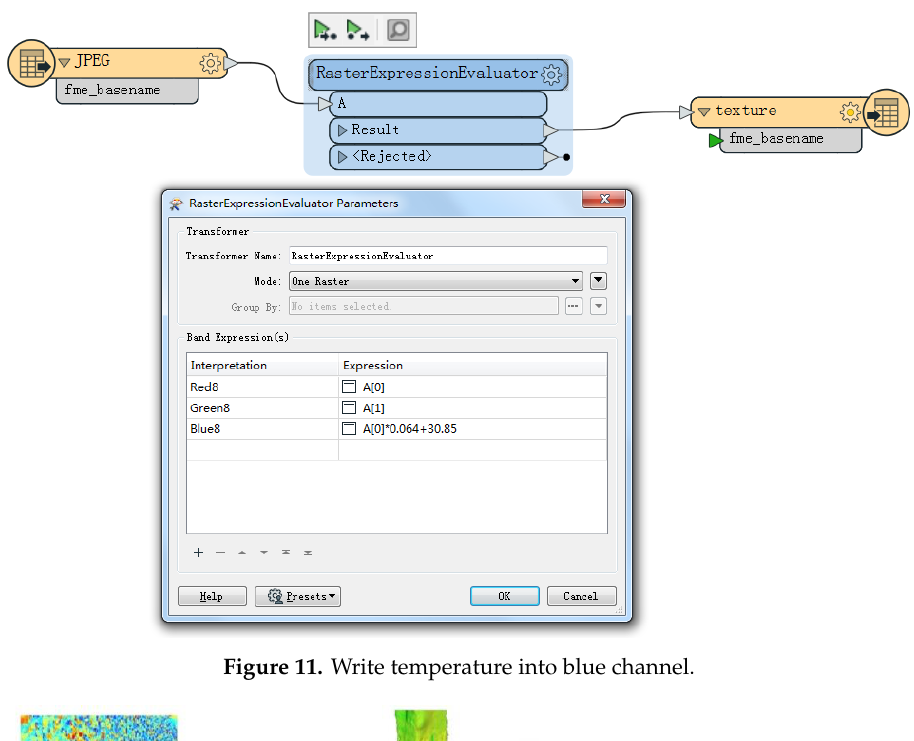
Figure 11. Write temperature into blue channel.